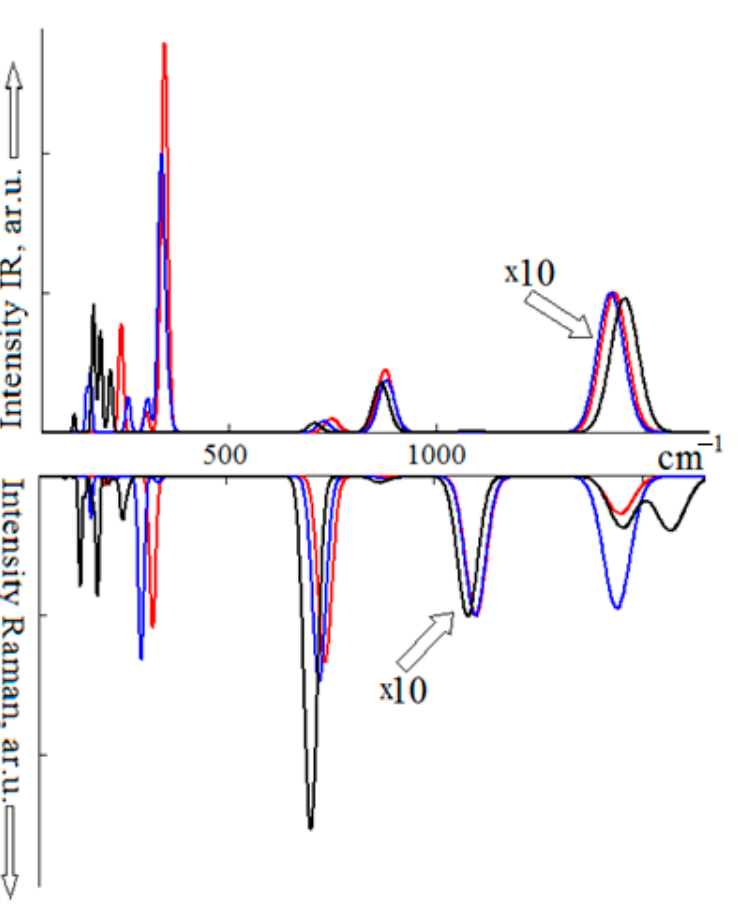
Figure 2. Infrared ( top ) and Raman ( bottom ) spectra of MgCO 3 (red), CaMg(CO 3 ) 2 (blue) and SrCO 3 (black). ×10 means that the intensity of the corresponding line should be increased 10 times.